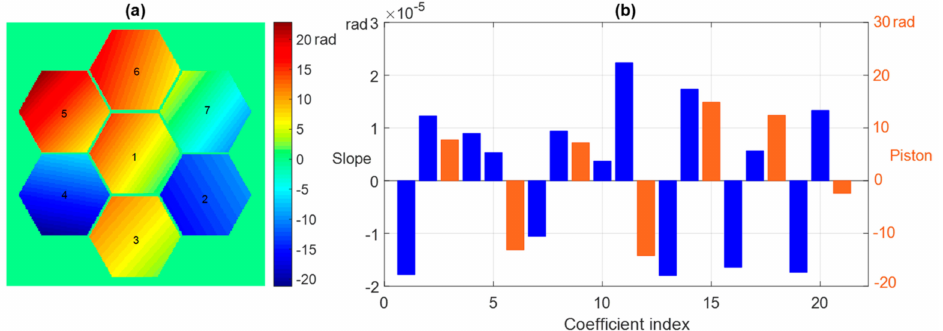
Figure 4. The ground truth phase error and coefficients. In figure ( a ), the hexagon segment is simulated according to the real size of JWST, with a diameter for each segment of 1.3 m and an image size of 256 × 256. The index of each segment is as the numbering shown. In figure ( b ), the bar in blue denotes the tip–tilt error and the orange is the piston error. The coefficient index is defined as ( a 1 , b 1 , c 1 , a 2 , b 2 , c 2 , . . . a 7 , b 7 , c 7 ), subscripted by the segment